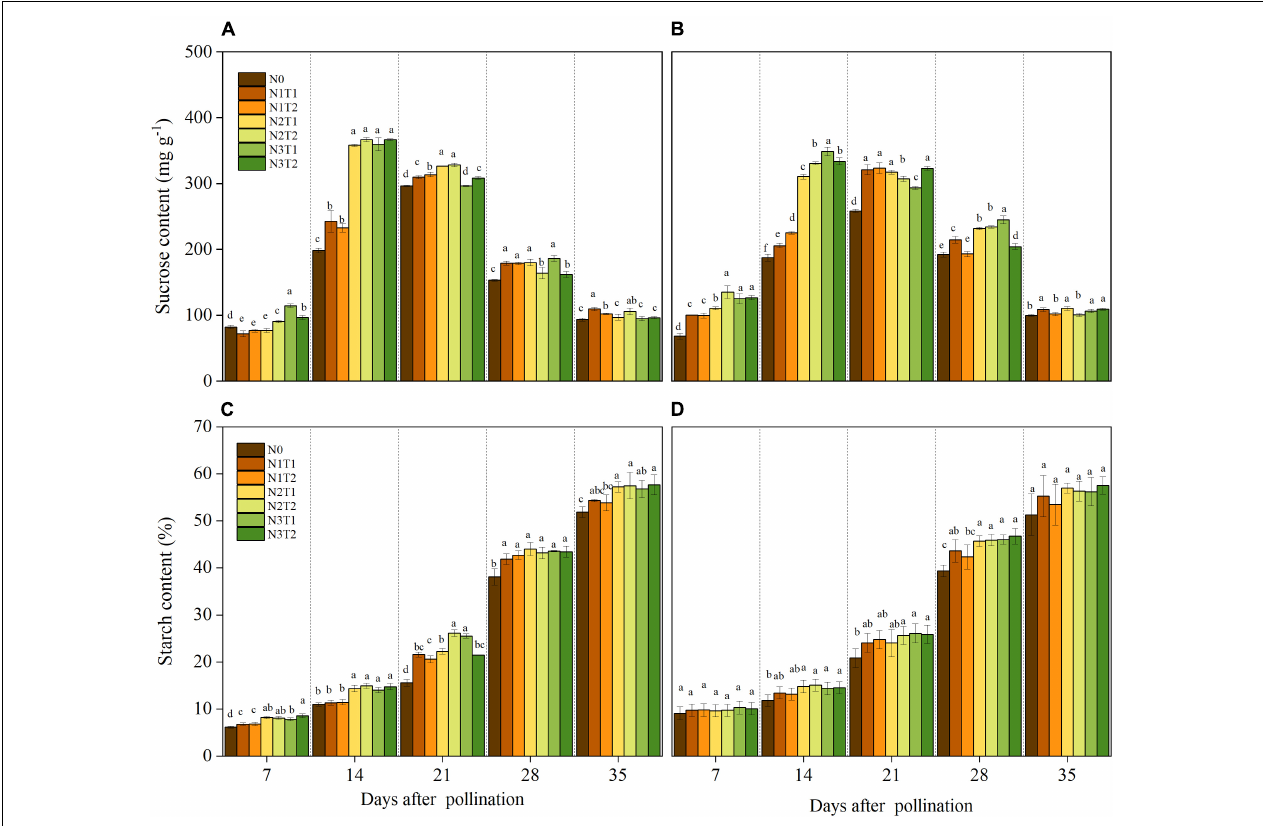
FIGURE 3 | Effects of N rate and time on the content of sucrose and starch in 2019 (A,C) and 2020 (B,D) . N rate, N0, no N fertilizer; N1, 100 kg N ha − 1 ; N2, 200 kg N ha − 1 ; N3, 300 kg N ha − 1 . N application time, T1, one-third of the full N rate corresponding to the treatment at sowing and the remaining two-thirds at V6; T2, one-third of the full N rate corresponding to the treatment at sowing, V6, and V11. Different letters indicate significant differences at p < 0.05.